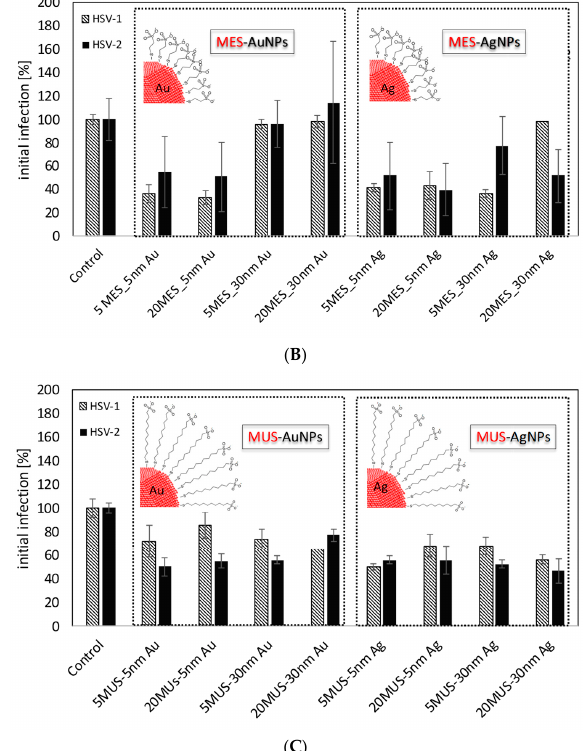
Figure 4. Inhibition of virus infection with the use of TA-conjugates ( A ), MES-conjugates ( B ), and MUS conjugates ( C ) of 5 and 30 nm AuNPs as well as 5 and 30 nm AgNPs. The efficiency of antiviral action was measured in plaque-forming units (PFU) and compared to untreated infected cultures. Results are expressed as % of untreated infection. 2.3. The Antiviral Mechanism of Functional Nanoparticles Cryo-TEM was used to visualize the interaction of HSV virus with functional nano- particles and to identify and specify the mechanisms responsible for the action of selected functional nanoparticles. The cryo-TEM images of sulfonate-functionalized nanoparticles and tannic acid-functionalized nanoparticles are presented in Figure 5.